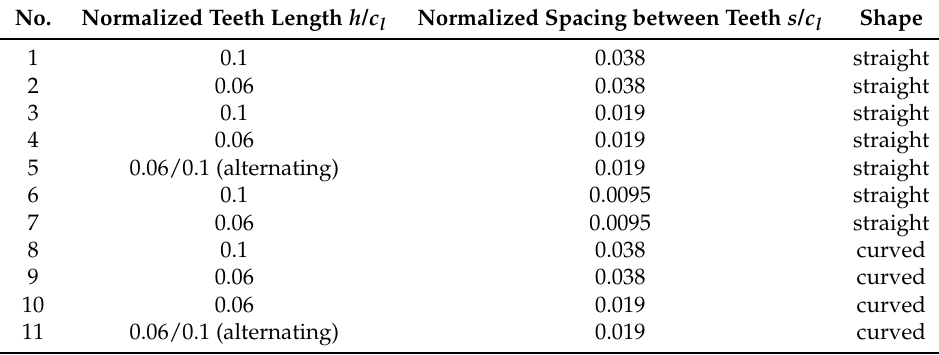
Table 2. Overview of comb structures used in the experiments (see schematic in Figure 4 for details).